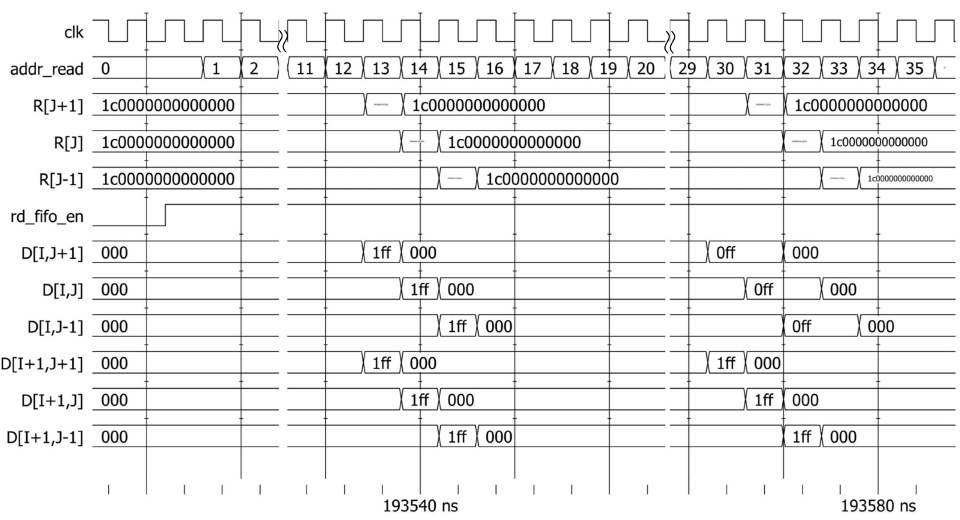
Figure 16. Timing diagram of the heterogeneous convolution window.